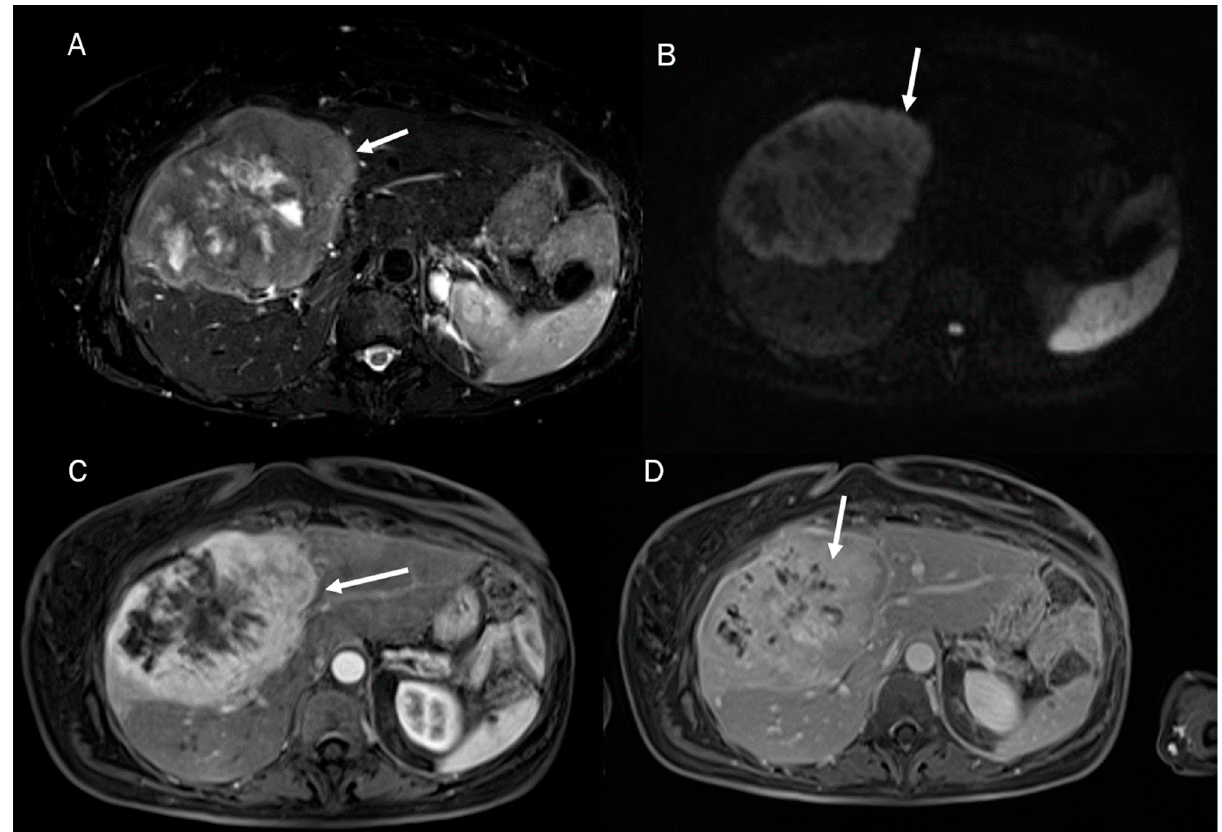
Figure 1. Combined hepatocellular cholangiocarcinoma MRI assessment: the lesion (arrow) shown in T2-W sequence ( A ); targetoid appearance, with restricted diffusion in b800 s/mm 2 ( B ); and progressive contrast enhancement during contrast study (arterial phase ( C ) and portal phase ( D )).